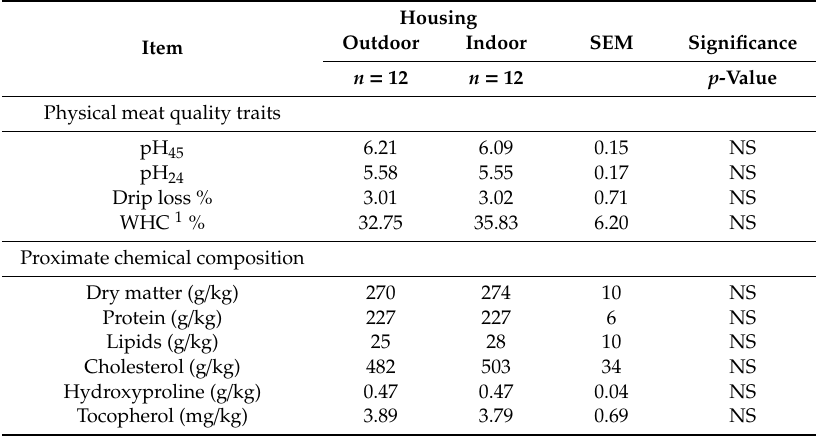
Table 5. Physical and chemical traits of longissimus lumborum muscle of Prestice Black-Pied pigs reared in di ff erent housing